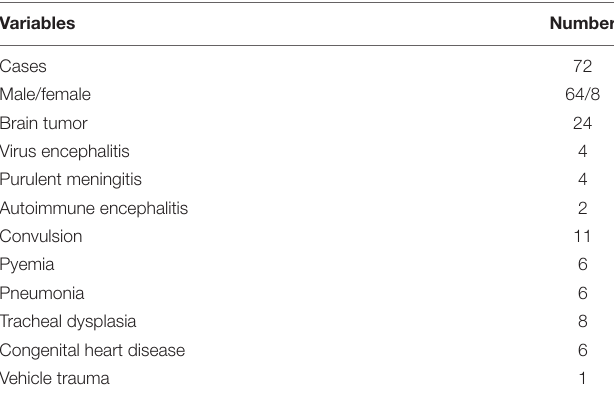
TABLE 1 | General information of the patients.